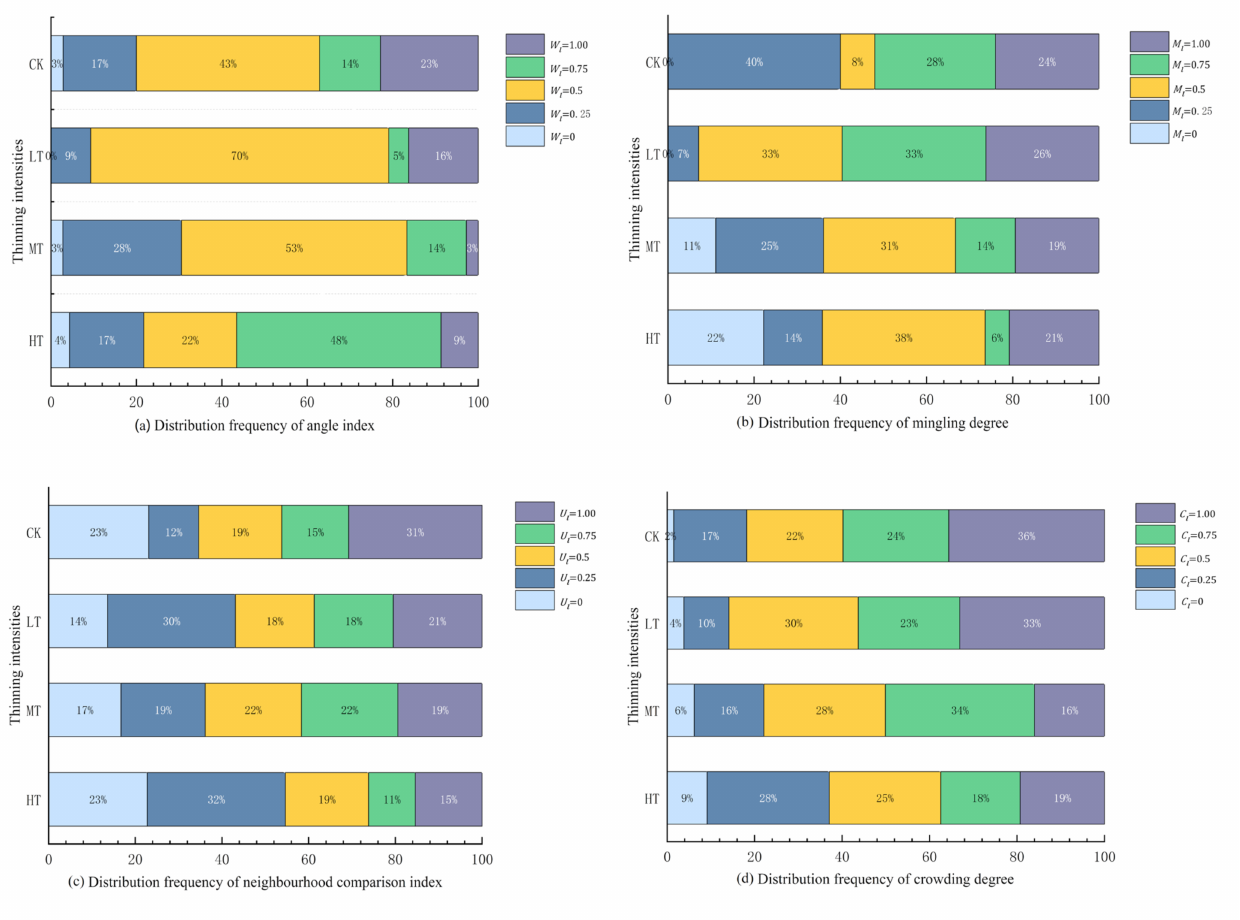
Figure 4. Distribution frequency of spatial structure index under different treatments. Pictures ( a – d ) represent angel index, mingling degree, neighbourhood comparison index and crowing degree,